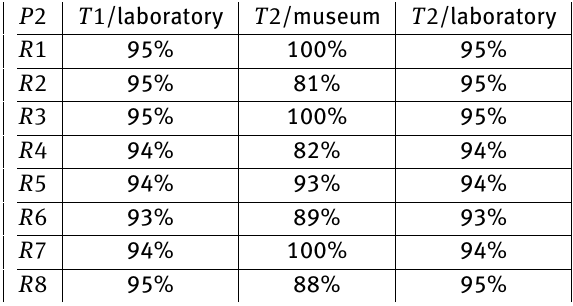
Table 1: The first and the third columns represent the performances of P 2 robots before and after the learning at the museum. The sec- ond column represents the performance of the P 2 robots tested on learned museum objects.